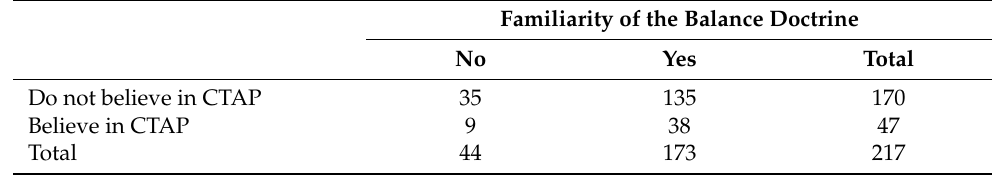
Table 3. CTAP crosstabulation familiarity of the Balance doctrine CTAP